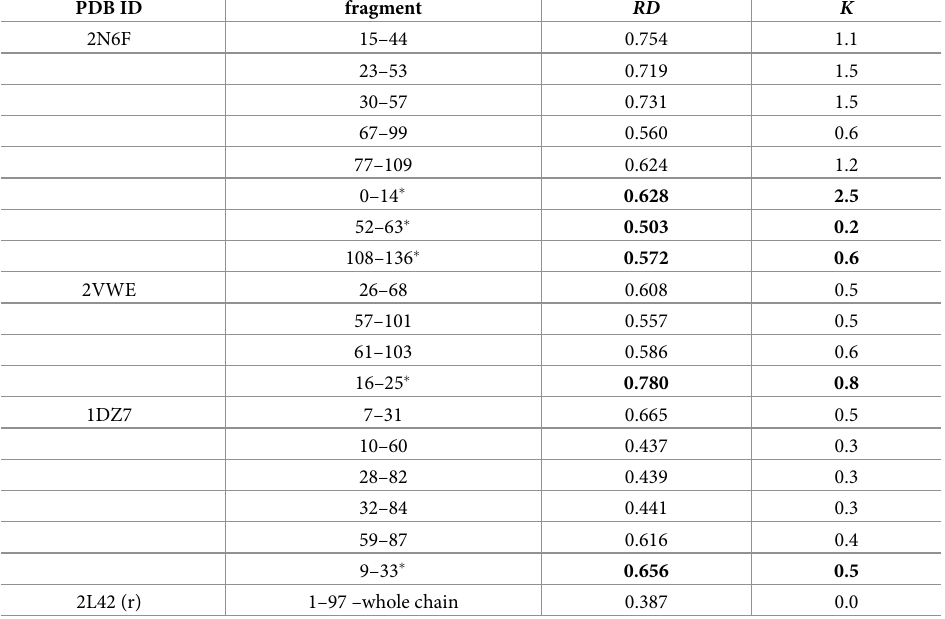
Table 2. The values of parameters RD and K for the chain’s fragments covered by the disulfide bonds (SS). The fragments marked with stars–are indicated in the DisProt database as IDRs. Numbering in accordance with RCSB database; (r): Reference protein.